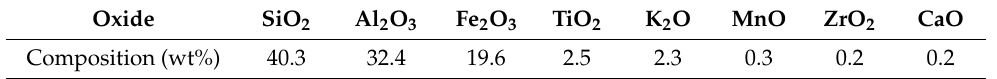
Table 2. Overall chemical composition of clays (XRF, major elements only, >0.1 wt%). Oxide SiO 2 Al 2 O 3 Composition (wt%)